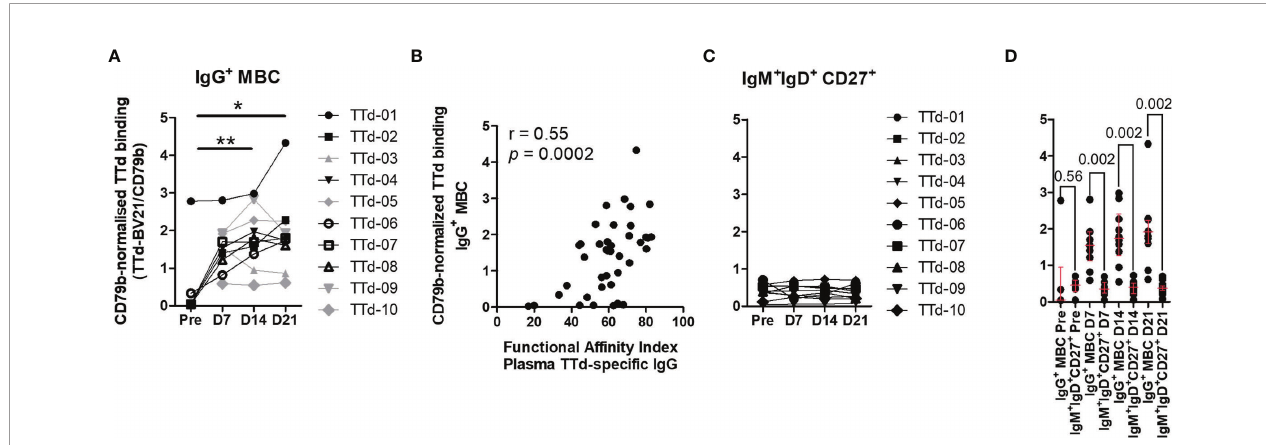
FIGURE 5 | Assessment of CD79b-normalised TTd tetramer binding to B cells before and after booster ADT vaccination. TTd tetramer binding of IgG + MBC and IgM + IgD + CD27 + B cells was assessed relative to expression of the BCR-associated molecule CD79b. (A) CD79b-normalised TTd tetramer binding of IgG + MBC (Friedman test, n = 6). Four individuals who had pre-vaccination frequencies of TTd + B cells <10 events per 3x10 5 lymphocytes were excluded from statistical analyses (shown in grey). (B) CD79b-normalised TTd tetramer binding of IgG + MBC was compared to the functional af fi nity index of plasma TTd-speci fi c IgG antibodies. (C) CD79b-normalised TTd tetramer binding of IgM + IgD + CD27 + B cells. (D) CD79b-normalised TTd tetramer binding of IgG + and IgM + IgD + CD27 + B cells were compared before and at days 7, 14 and 21 post-ADT (Wilcoxon ’ s signed rank test). * and ** denote p < 0.05 and p < 0.005,